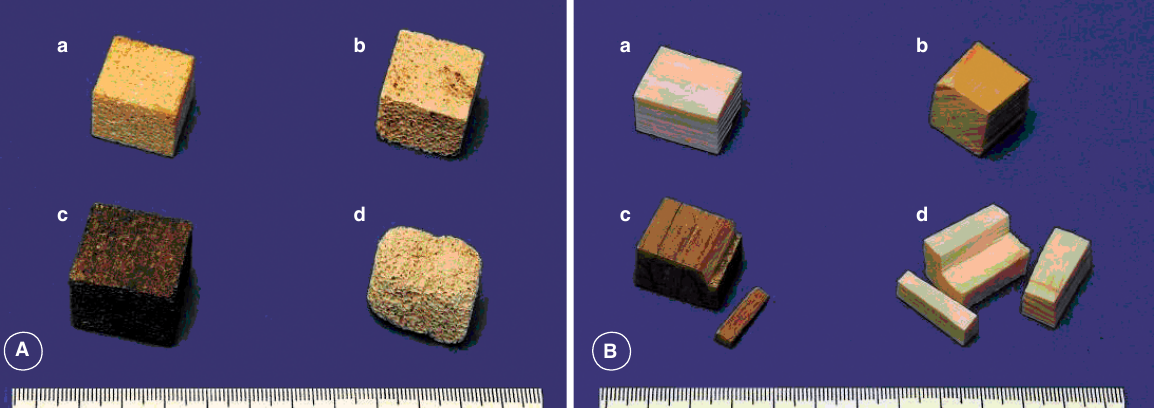
FIG. 1A and B Physical appearance of blocks prepared from cervical vertebrae (A) and metacarpus shaft (B) after 30 days a = Bone sample prior to immersion in a fluid, b = Bone sample immersed in distilled water for 30 days, c = Bone sample immersed in rumen fluid for 30 days, and d = Bone sample immersed in artificial saliva for 30 days TABLE 4 The effects of distilled water (DH O), artificial saliva, and rumen fluid on cervical vertebrae bone samples 2 Bone